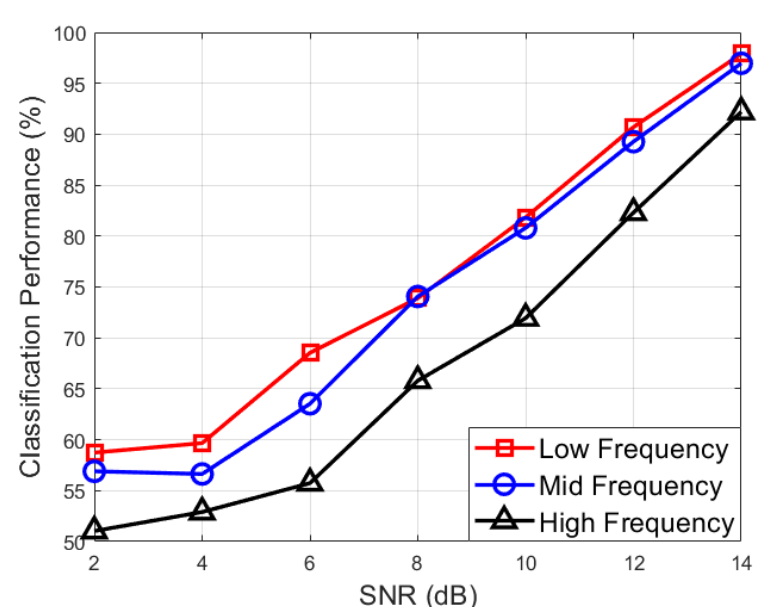
Version June 4, 2022 submitted to Remote Sens. 14 of 19